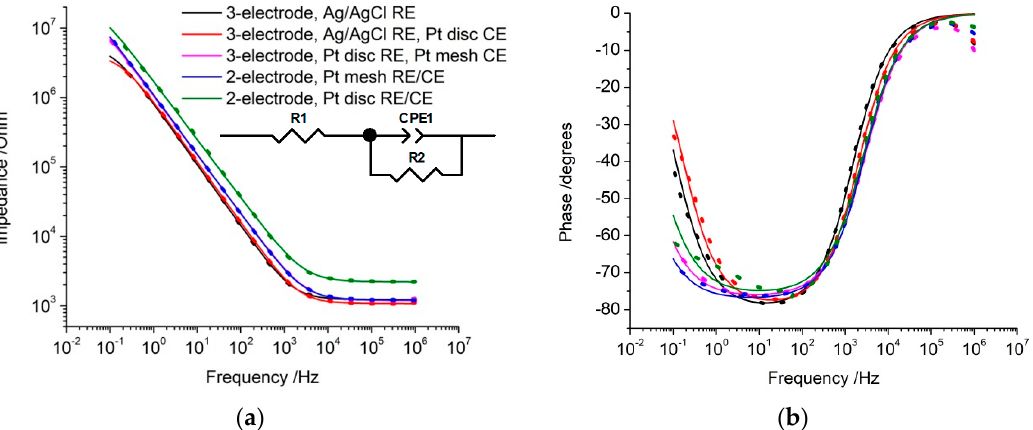
Figure 3. Electrochemical impedance of a platinum electrode in degassed 0.1 M NaCl at 0 V with an ac amplitude of 5 mV in a three- or two-electrode configuration. Equivalent circuit used to model the impedance is shown.